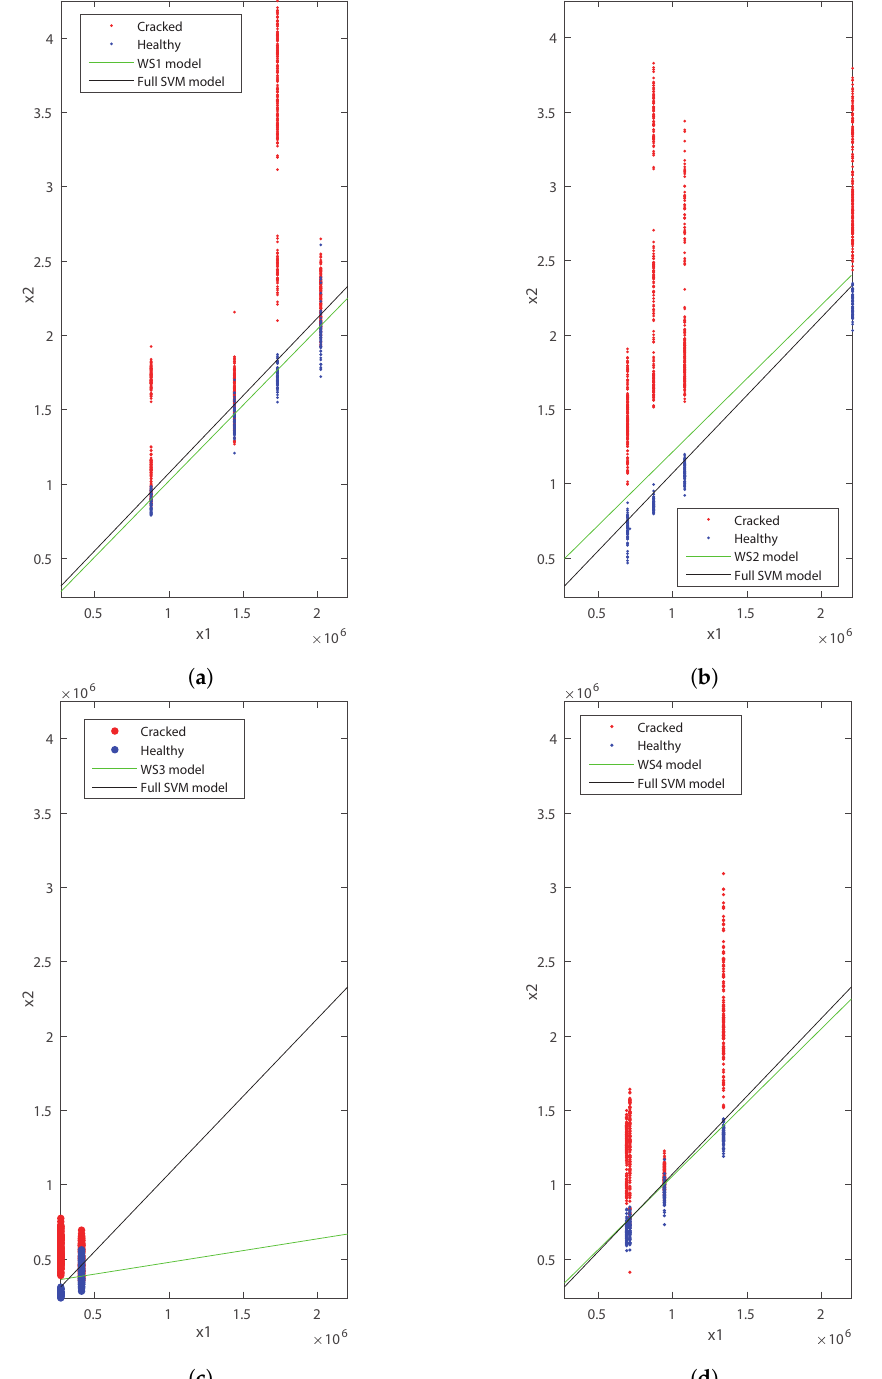
Figure 10. Full linear Support Vector Machines (SVM) model and x 1 (V 2 /s) vs. x 2 in (V 2 /s) for ( a ) the WS1 features and WS1 model; ( b ) the WS2 features and WS2 model; ( c ) the WS3 features and WS3 model; and ( d ) the WS4 features and WS4